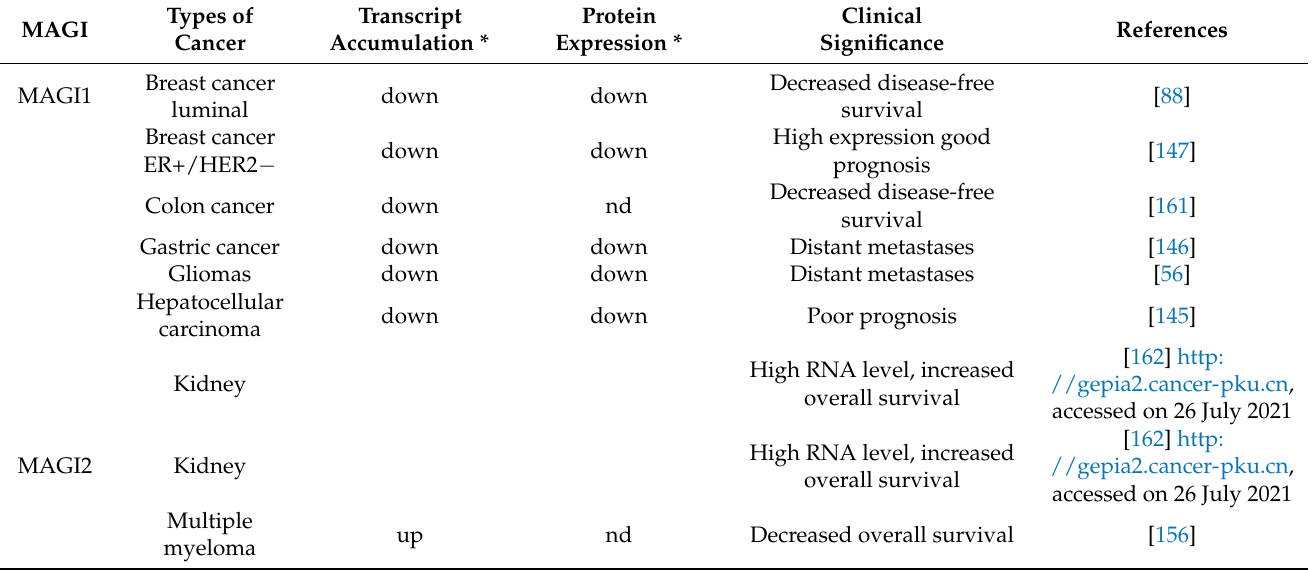
Table 3. MAGI expression and cancer